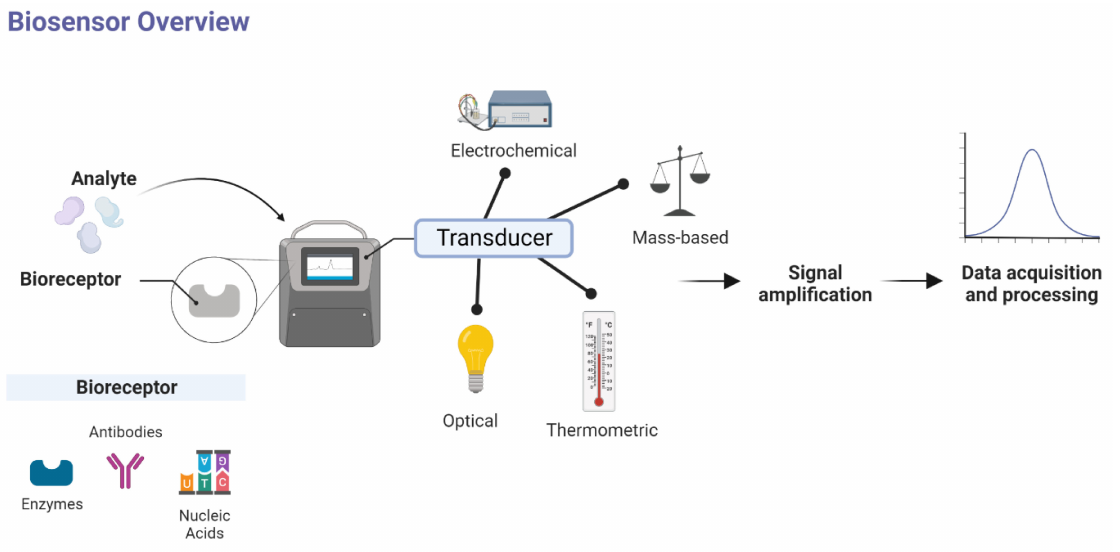
Figure 2. Schematic diagram and operational principle of biosensors. The sample is introduced to the biosensor; the bioreceptor interacts with the target molecule. The transducer coupled with the receptor transfer the respective signal to the amplifier, then the amplified signal is converted into readable